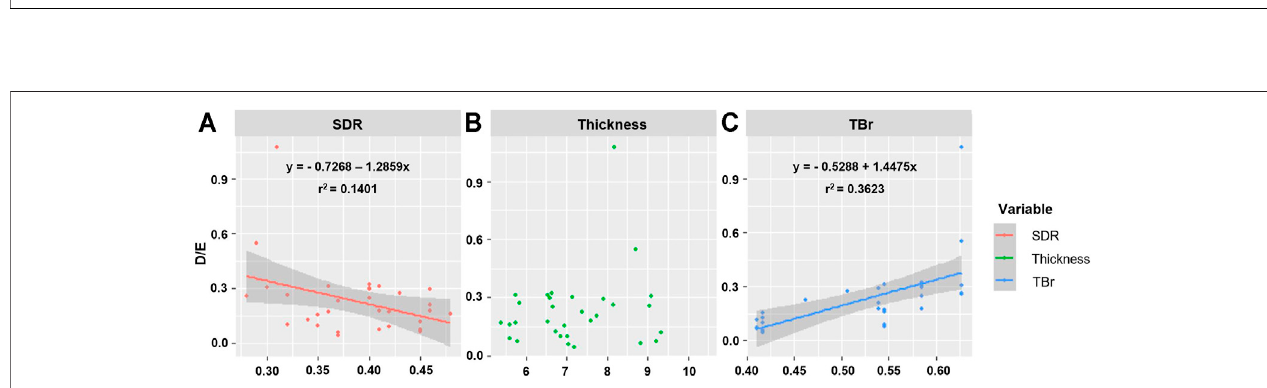
FIGURE4| Comparisonofultrasoundenergyattenuationratesaccordingtotheratioofthecorticalbonetothetrabecularbone. (A,B) XY-axisandYZ-axisimages of the ultrasound beam according to thickness and ratio ofthe phantom. (C, D) Measurementresults ofpeak pressure attenuation of ultrasonic energyaccording to the ratioandthickness.Comparisonofultrasoundenergyattenuationratesaccordingtoskullvariables.(A – C)XY-axisandYZ-axisimagesoftheultrasoundbeamaccording to thickness, ratio, and porosity of the phantom (D – F).